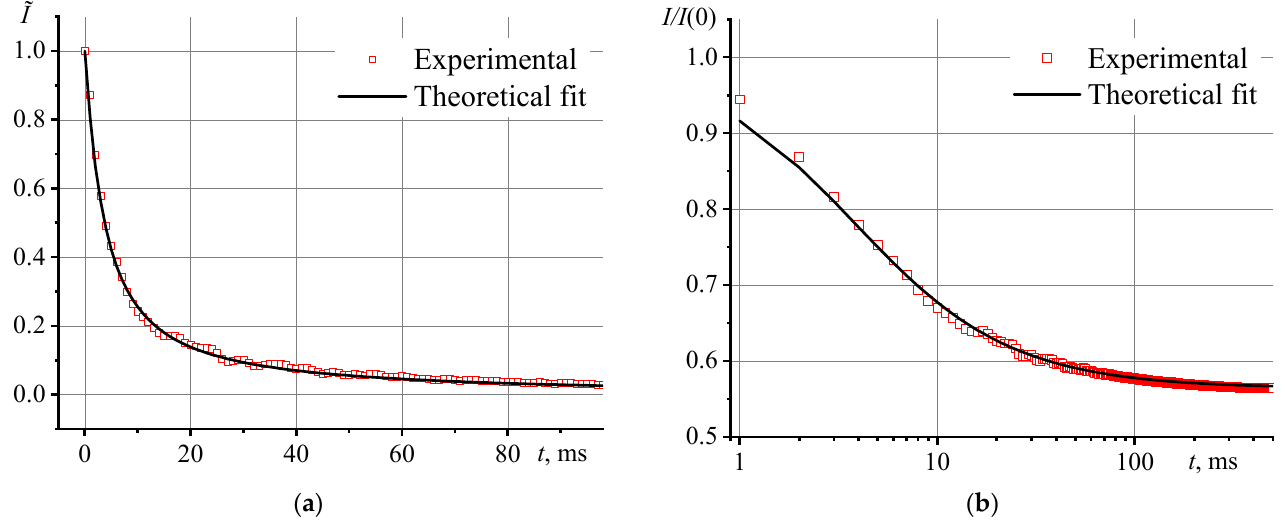
Figure 2. Transient curve for an aqueous solution of ferroin (1 µ mol/L): ( a ) in linear scale form for the first 100 ms and ( b ) in logarithmic scale for the first 500 ms (measurement parameters are presented in Table